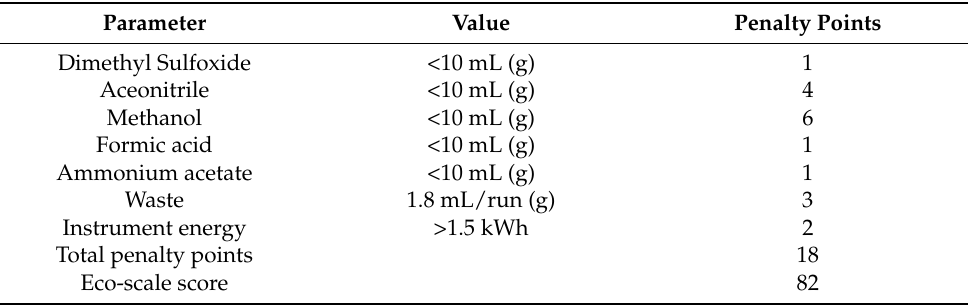
Table 6. The Penalty Points of the Method for the Determination and Quantitation of the Tamatinib in